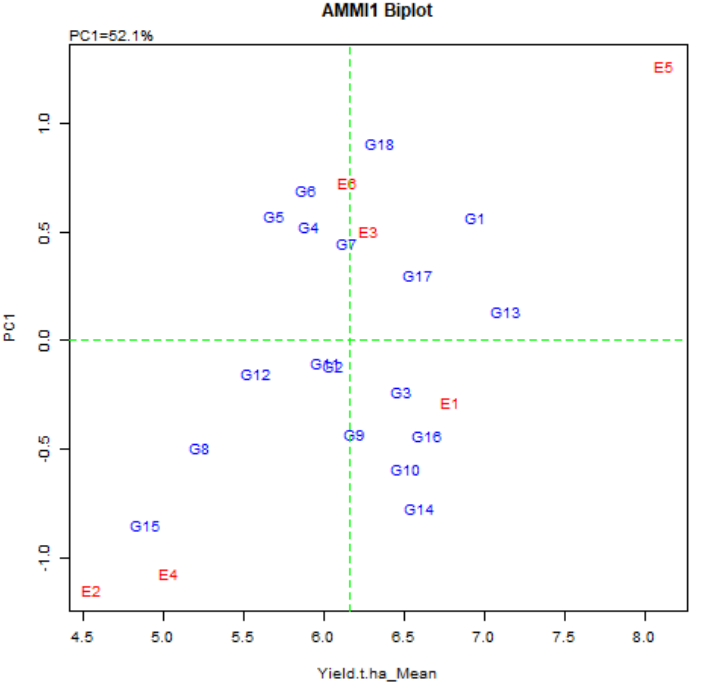
Figure 2. AMMI 1 biplot for grain yield (t/ha) of 18 elite rice genotypes (G) and six environments (E) indicating genotypic and environmental IPCA scores. (First principal component of the interaction = IPCA1, G1 = BR9627-1-3-1-10, G2 = IR92860-33-CMU1-1-CMU2-AJYB, G3 = BR9154- 2-7-1-2, G4 = BR9620-2-7-1-1, G5 = BR9620-2-4-1-5, G6 = BR9621-B-1-2-11, G7 = BR9625-4-1-2-8, G8 = BR9625-B-2-4-9, G9 = BR9625-B-1-4-6, G10 = BR9625-3-1-12, G11 = BR9626-1-2-12, G12 = IR